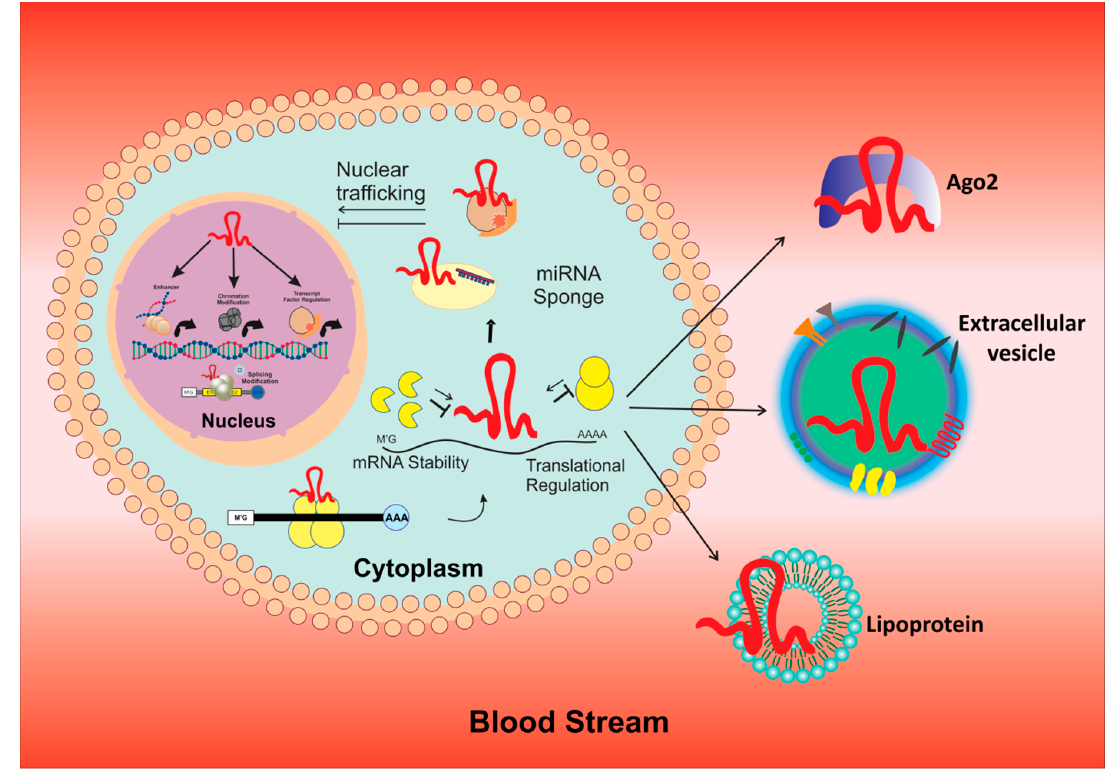
Figure 2. Illustrates the mechanism involved in process of biogenesis and function of lncRNA.